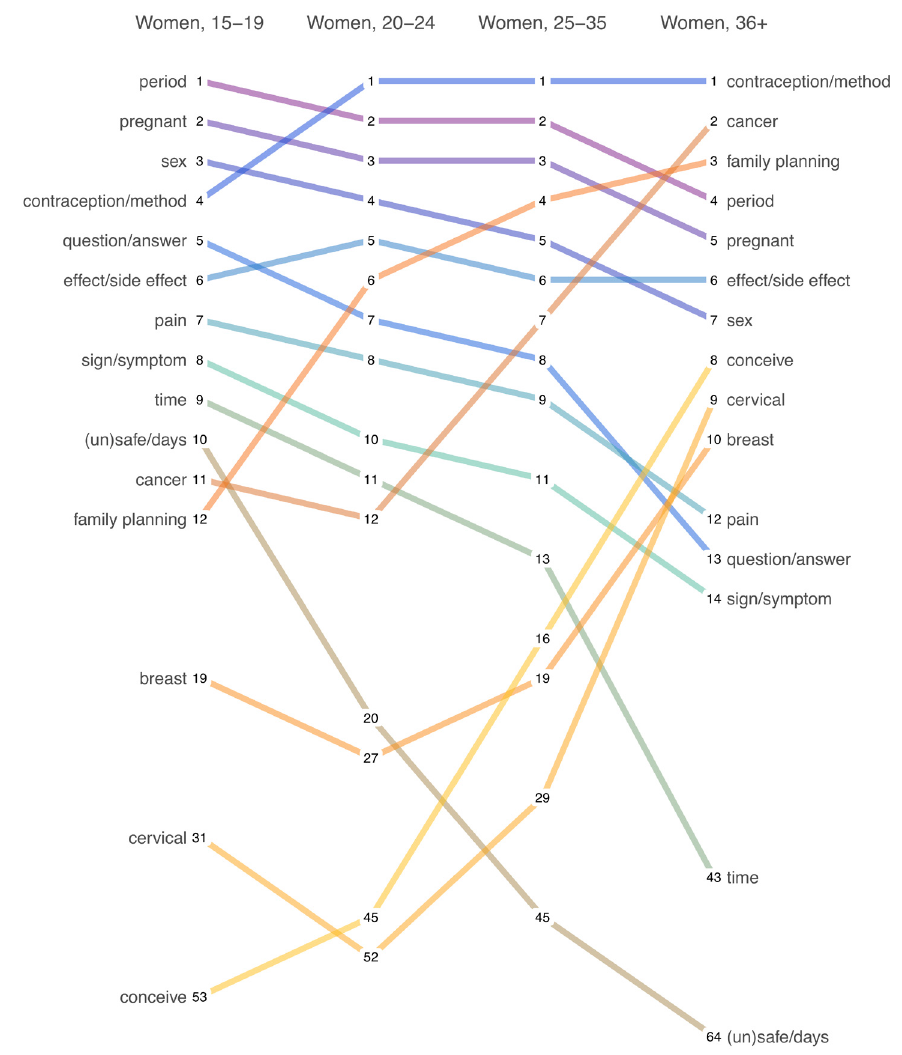
Figure 6. Rank order of the most common words used in incoming messages (English) by age category, women. This is a forced-rank chart because two words could have the same frequency of usage, but no ties are awarded.